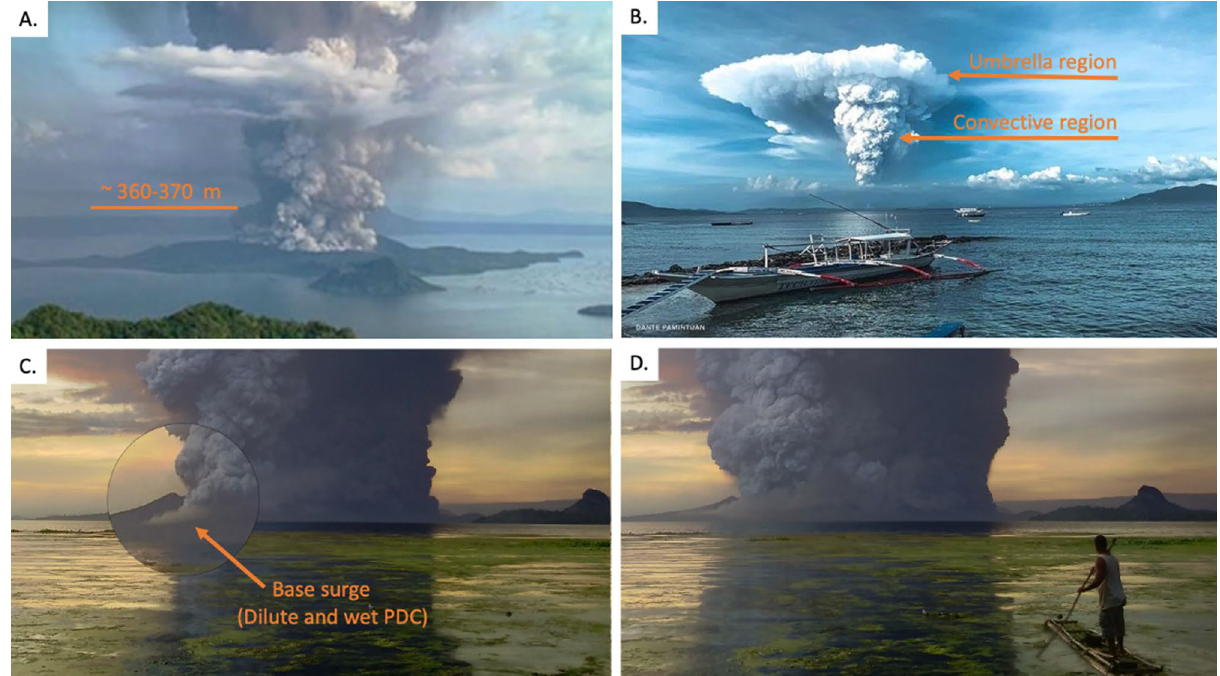
Figure 1. Photographs and screenshots of videos of the 12 January 2020 eruption of Taal. ( A ) Eruption showing a lateral basal cloud with an estimated fountain height of 360-370 m. Photo by Johnny Alegre (CC- BY SA4.0). ( B ) Umbrella cloud and convective regions. Photo by David Comes Lorenzo. ( C ) Magnified view of base surges (dilute and “wet” PDCs) forming in the southeast sector of TVI; ( D ) Dust covering the southeastern slopes of TVI. Photos C and D by Andres